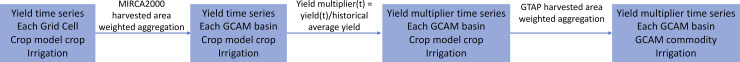
Schematic of data processing.Schematic illustrating the processing of global gridded yield time series into time series of yield multipliers for GCAM commodities in each basin under perfect irrigation and rainfed conditions.